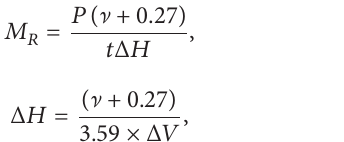
Figure 6: Fatigue life as the function of stress level 0.5 MPa after UV 8d aging.